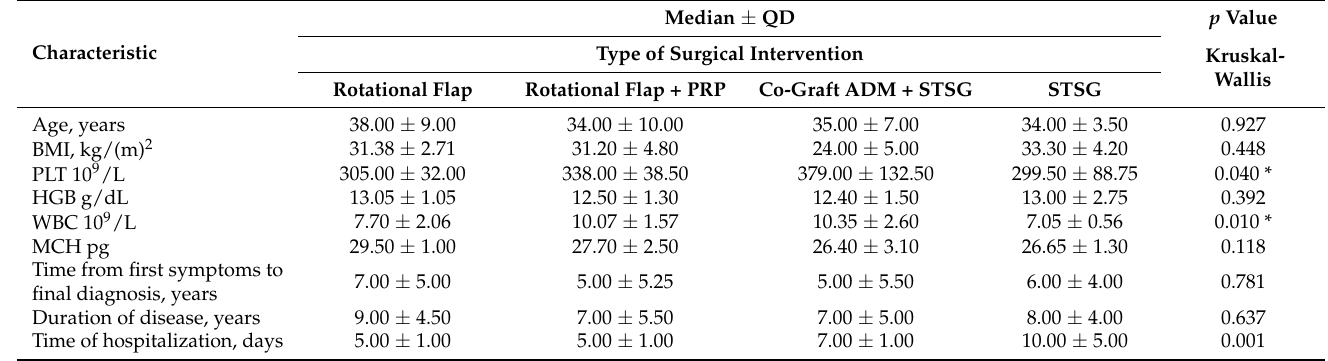
Table 4. Clinical characteristics of patients regarding the type of surgical intervention.